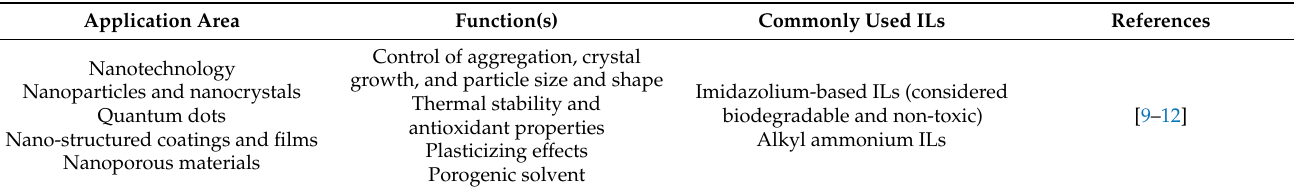
Table 1. Applications and functions of commonly used